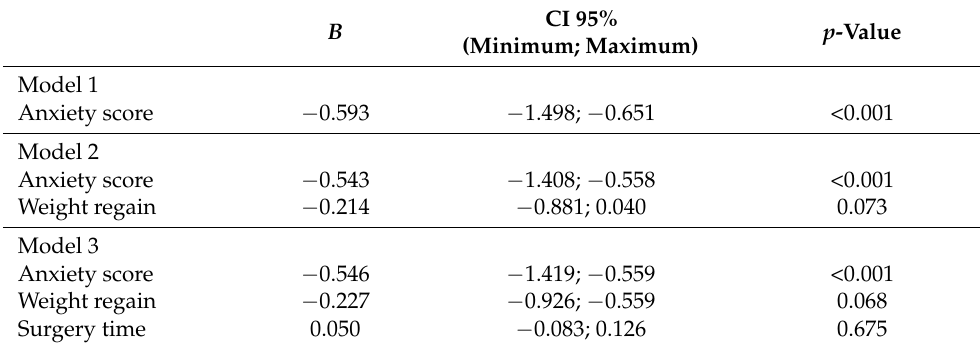
Table 3. Linear regression between the anxiety symptoms score and the general emotional component of the quality of life of women more than 24 months after undergoing bariatric surgery.